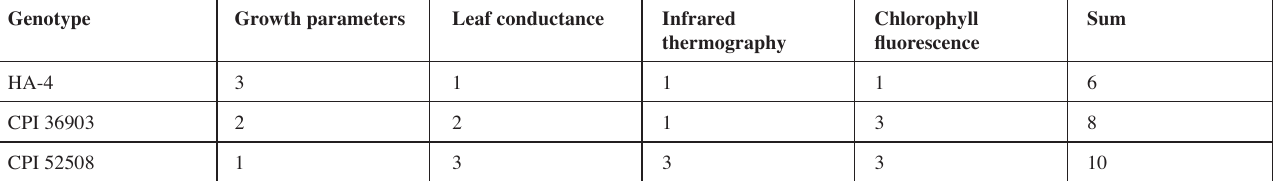
Tab. 1: Result summary of used stress methods. In this case each genotype is assigned to a value of one to three. Three corresponds to a low negative influence and one represents a strong negative influence of drought for the pants. Genotypes with similar values get the same rating.